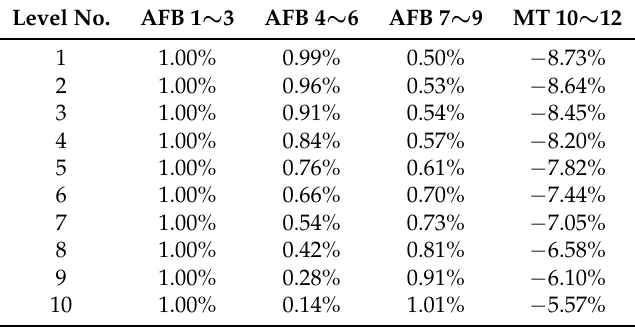
Table 3. The assigned initial strain in the cytoskeletal components. Level